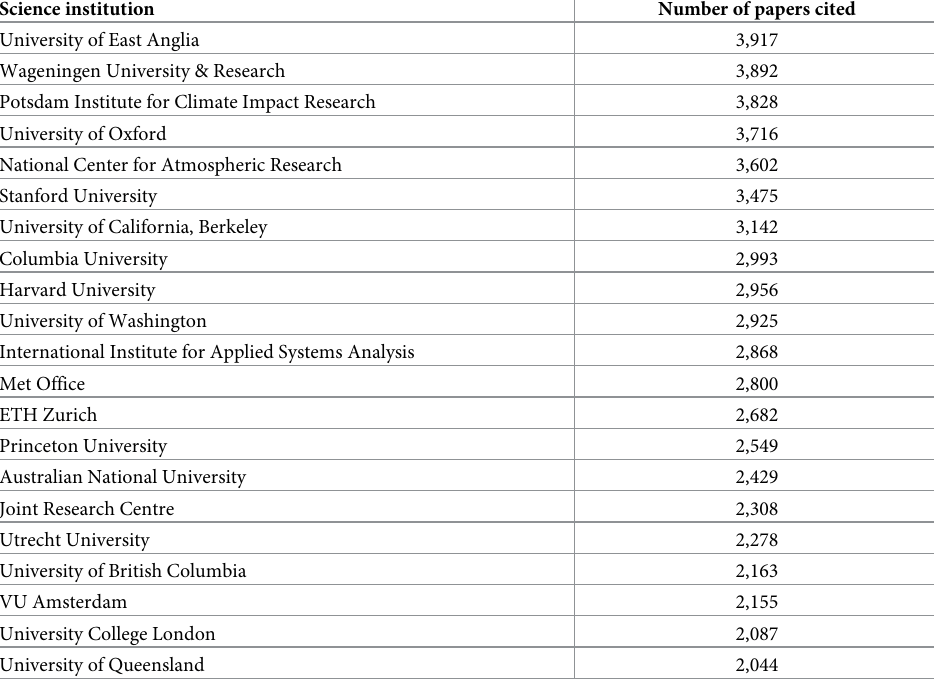
Table 4. Scientific institutions with the highest number of papers cited in policy documents. The table includes all institutions with more than 2000 papers